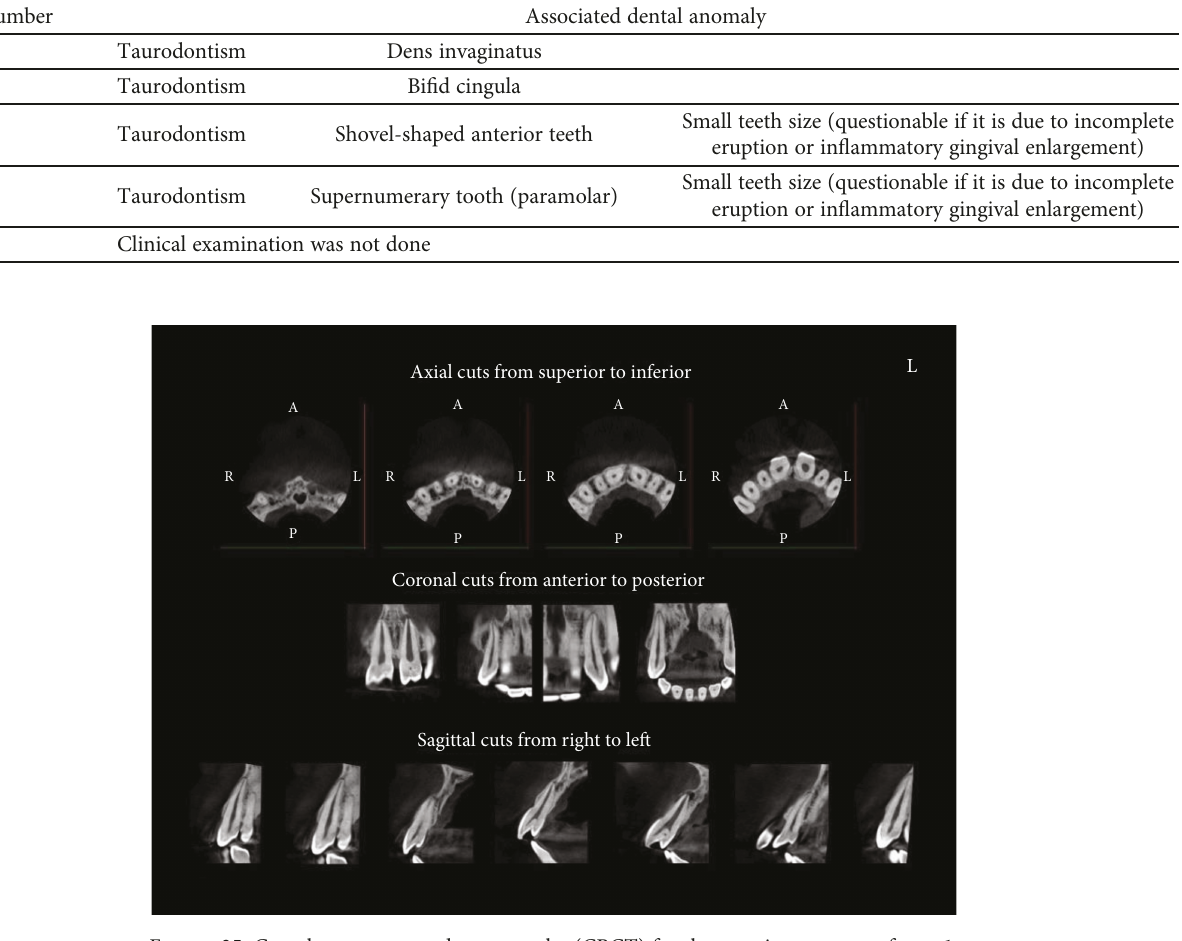
Table 2: Summary of dental anomalies associated with talon cusp in the report.